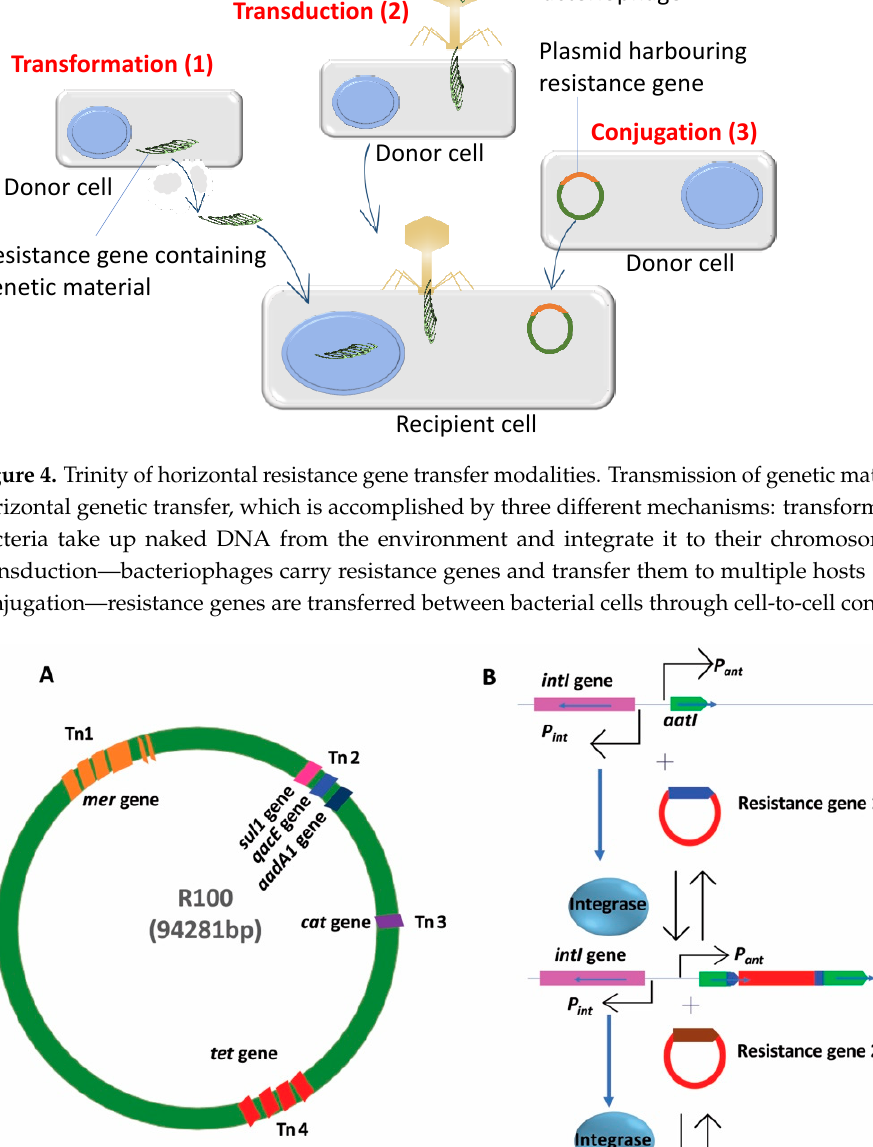
Figure 5. Antibiotic resistance via acquisition of mobile genetic elements (MGEs). The structure of a resistance plasmid (R100) (panel A ) and the process of resistance gene acquisition (panel B ) are illustrated. Resistant plasmid harbouring many different resistance genes as part of transposon (Tn) element can confer multidrug resistance by a single conjugation event. Integron mediated resistance gene capture system is frequently observed in many different clinical bacterial species. Integrase (transcribed under a downstream promoter ( Pint )) catalyzes the insertion of an integron.